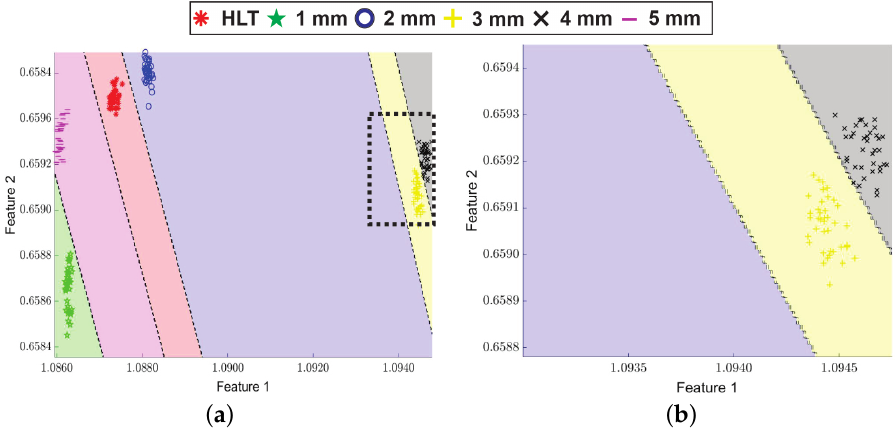
Figure 11. Projection of the decision regions for the multiple fault classification computed by the proposed FFNN-based classifier when the induction motor is driven at 60 Hz by using a VFD: